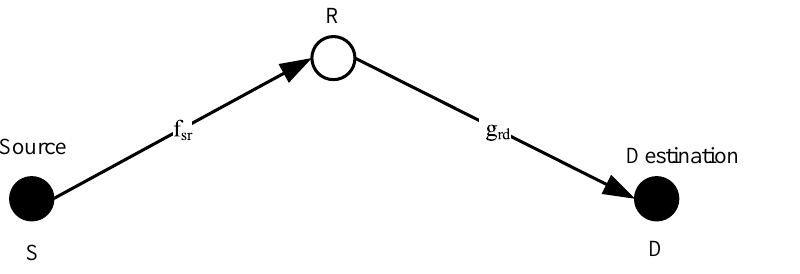
Figure 1. Half-duplex EH system.